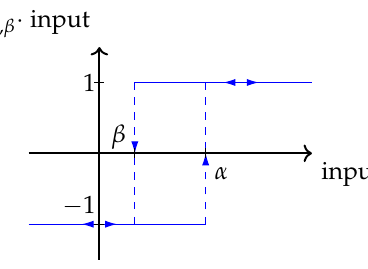
Figure 2. Definition of the fundamental hysteresis operator ˆ γ αβ . When the input is in the range ( α , β ) , the output is positive if the input reached this range from above and negative if it was reached from